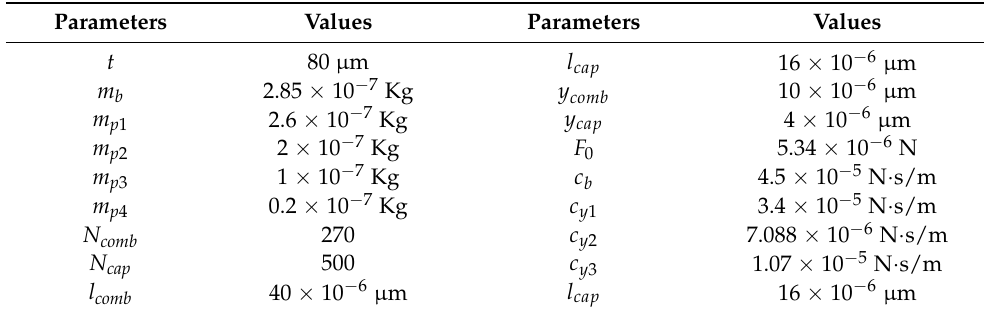
Table 1. The parameters of the